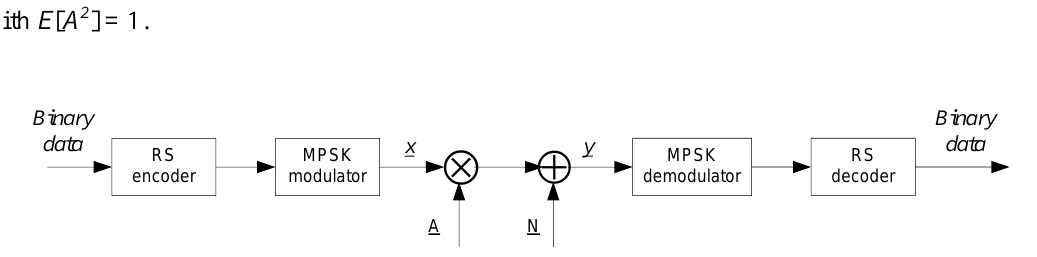
Figure 3. Signal transmission model (Jamali and Le-Ngoc,